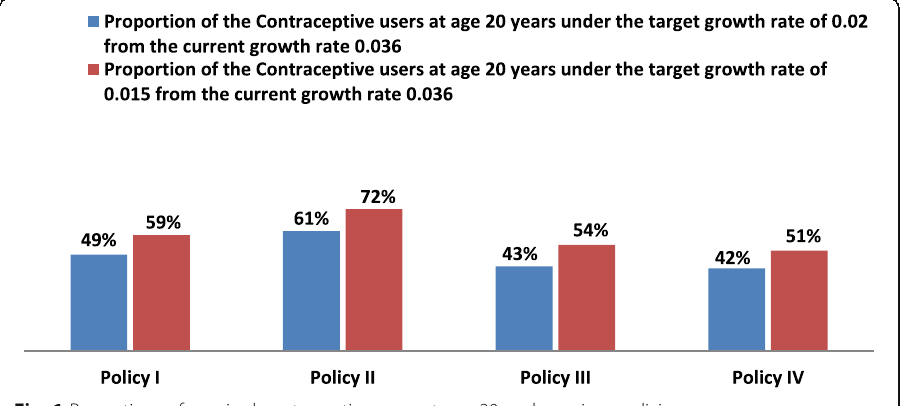
Fig. 1 Proportions of required contraceptive users at age 20 under various